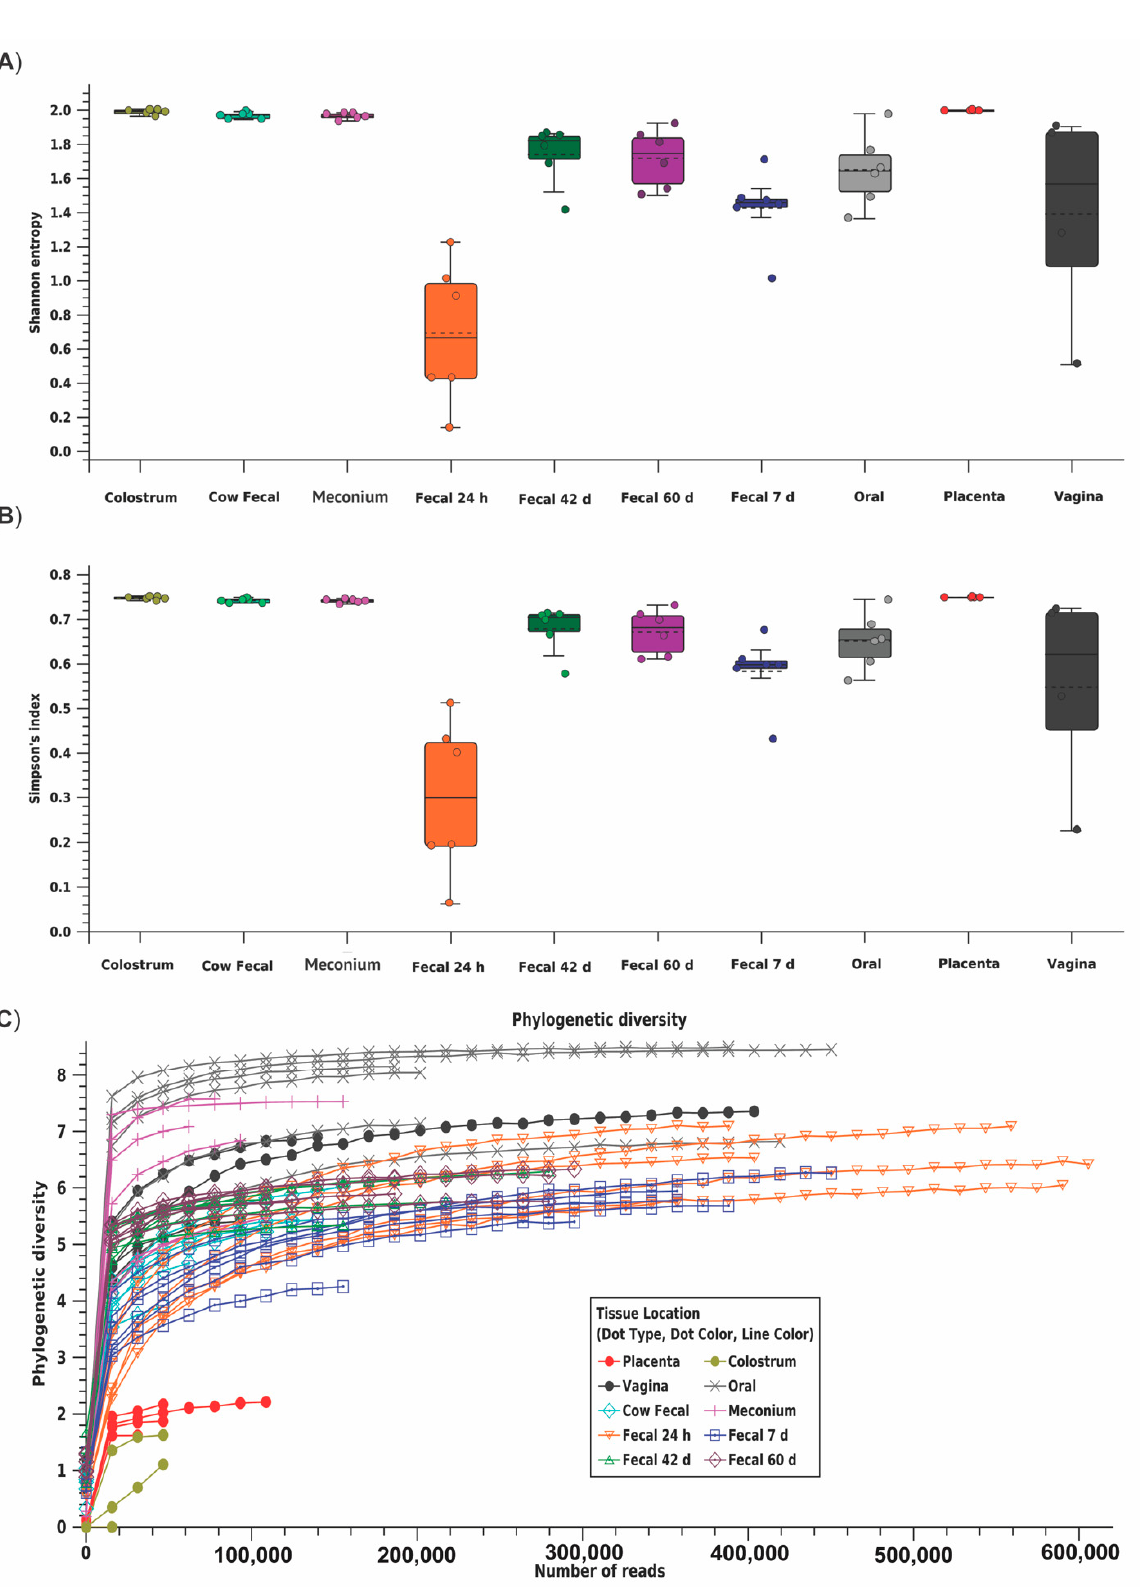
Figure 1. Alpha diversity, or microbial diversity within a sample, as measured by ( A ) Shannon entropy, ( B ) Simpson’s index, and ( C ) phylogenetic diversity for each maternal (placenta, colostrum, oral, fecal, n = 6; vaginal, n = 4) and calf (meconium, 24 h, 7d, 42 d, and 60 d fecal; n = 6) microbiome sample type from multiparous Holstein cow–calf pairs. Calf feces at 24 h had reduced diversity compared to other calf feces timepoints using Shannon entropy and Simpson’s index. Placenta and colostrum had lower phylogenetic diversity than other maternal and calf microbiome sample types.